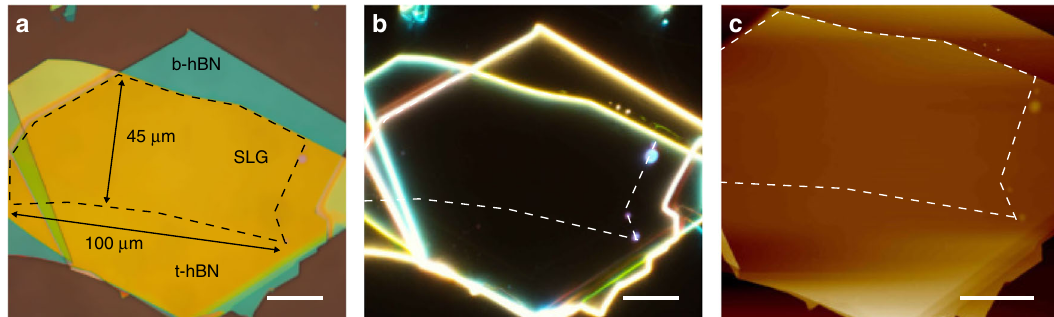
Fig. 2 Optical images and AFM scans of a heterostructure after cleaning. a Optical t-hBN: top hBN. b-hBN: bottom hBN. SLG: single layer graphene. b Optical dark fi eld image of the sample. c AFM. The dashed lines show the location of the SLG within the heterostructure. Scale bars 20 μ